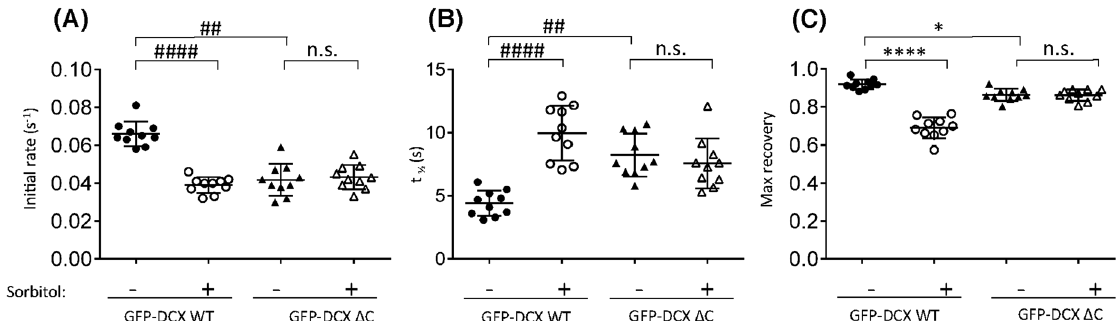
Figure 6. Hyperosmotic stress slows the dynamic association of DCX, but not DCX Δ C, with MTs. ( A – C ) The recovery of the ROI fluorescence for GFP-DCX WT and GFP-DCX Δ C under basal or sorbitol treatment conditions. Results are for the mean ± SEM for ( A ) the initial rate of recovery of fluorescence for GFP-DCX WT or GFP-DCX Δ C in the photobleached area (estimated over the initial 6 s post-bleach), ( B ) the time to reach half-maximal recovery of fluorescence (t 1/2 ), and ( C ) the fluorescence maximum recovery for GFP-DCX WT or GFP-DCX Δ C in the bleached area. Error bars represent the standard error of the means and asterisks and hash symbols indicate values calculated to statistically significantly different ( * p ≤ 0.05, **** p ≤ 0.0001 and ## p ≤ 0.01, #### p ≤ 0.0001 n = 10 cells in each of three independent experiments. n.s. = not